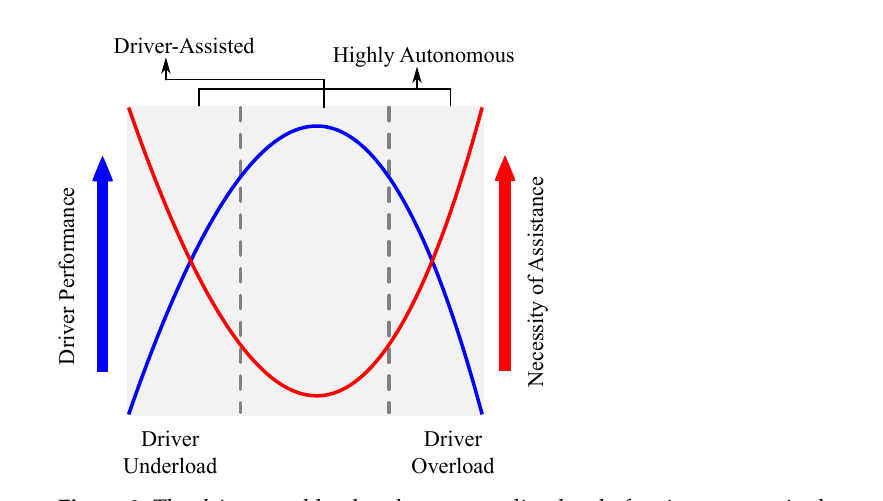
Figure 2. The driver workload and corresponding level of assistance